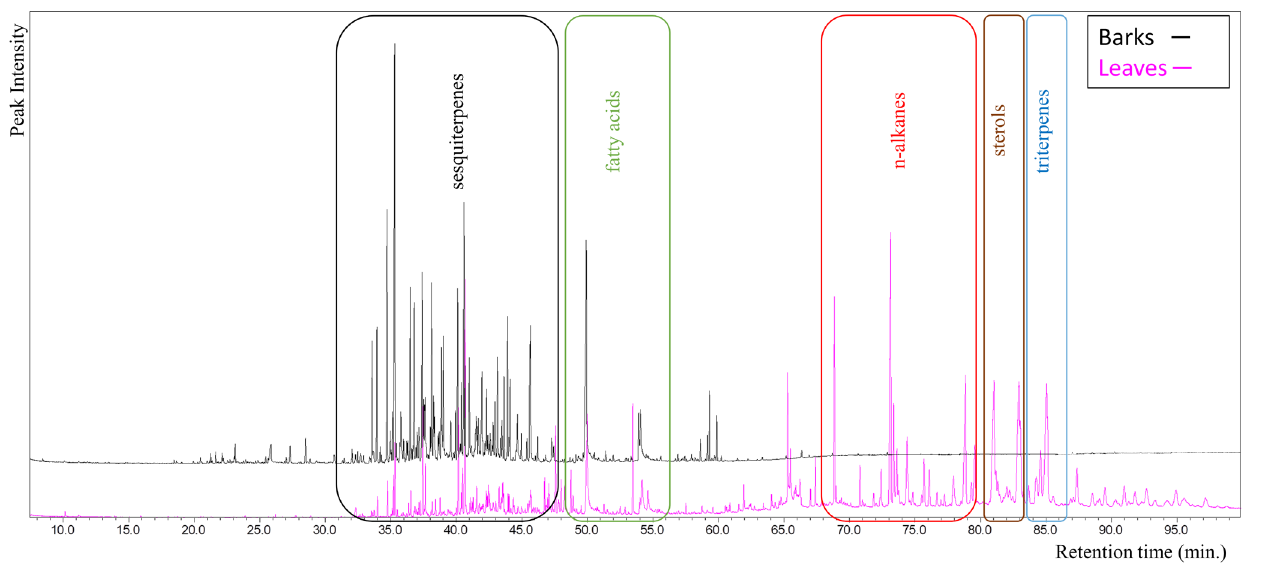
FIGURE 1 - Chromatogram analysis of the essential oil from C. leptophloeos barks (black) and leaves (pink) analyzed by GC/